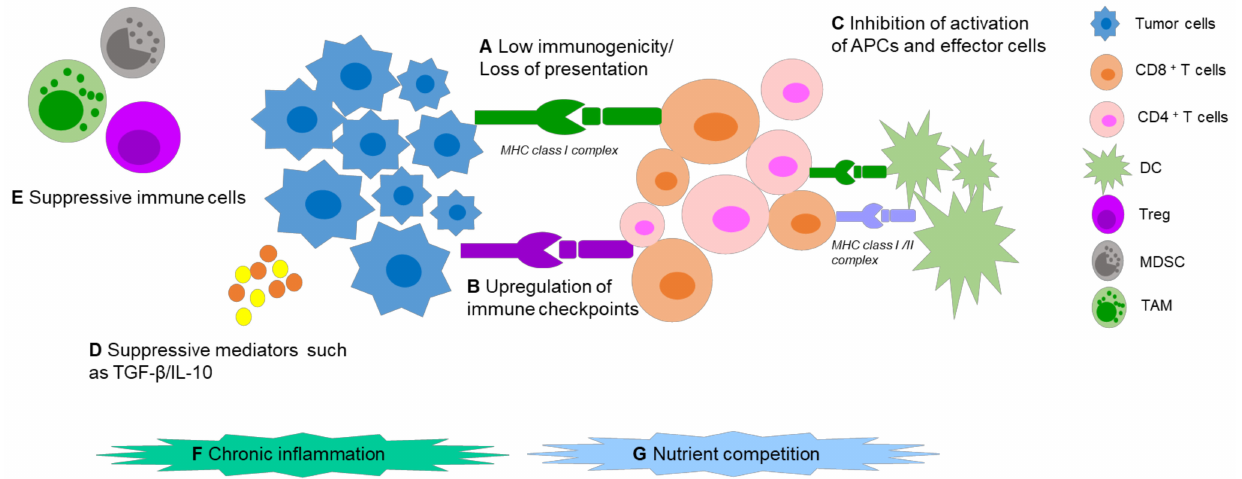
Figure 1. Mechanisms of tumor immune escape. ( A ) Tumor-associated antigens show low im- munogenicity and/or develop several antigen presentation problems. ( B ) Upregulation of immune checkpoints like PD-1 on T-cell surface or its ligand PD-L1 on tumor surface can cause T-cell anergy and inhibit the antitumor immune response. ( C ) Low secretion of immune stimulatory molecules in the TME, like IL-2, which inhibits the activation of APCs and other effector cells such as CD8 + /CD4 + T cells. ( D , E ) Production of immunosuppressive cytokines by tumor cells, such as TGF- β and IL-10 and recruitment of several immunosuppressive cells like regulatory T cells (Tregs), Tumor-associated macrophages (TAMs) and myeloid-derived suppressor cells (MDSCs), are able to attenuate anti- tumor immune response. ( F , G ) Chronic inflammation and nutrient competition promote immune dysfunction. Abbreviations: MHC (major histocompatibility complex); CD (cluster of